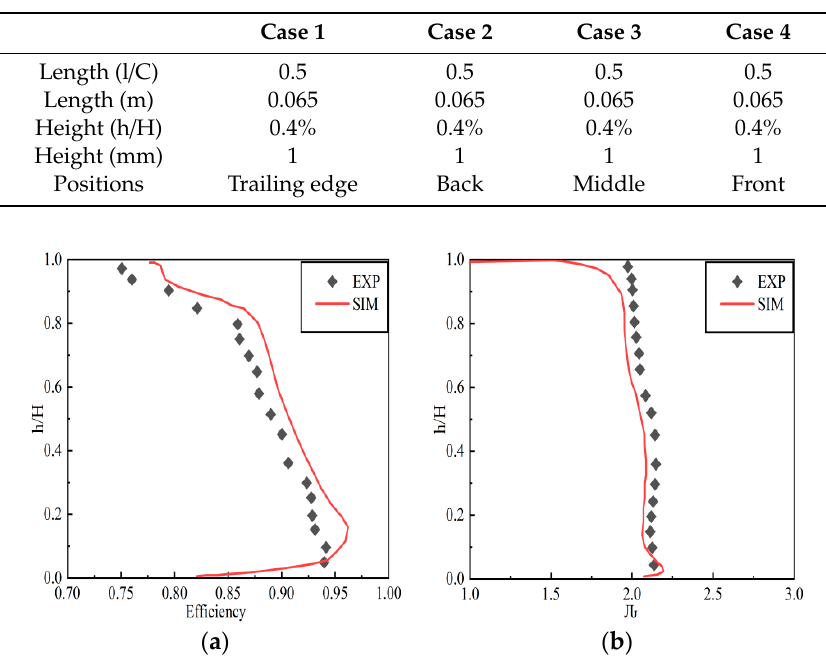
Figure 3. Comparison between numerical calculations and experimental results. ( a ) The distribution of pitch-averaged e ffi ciency of the ROTOR 37 in the 0.98 chocking mass condition; ( b ) the distribution of pitch-averaged pressure ratio of the ROTOR 37 in the 0.98 chocking mass